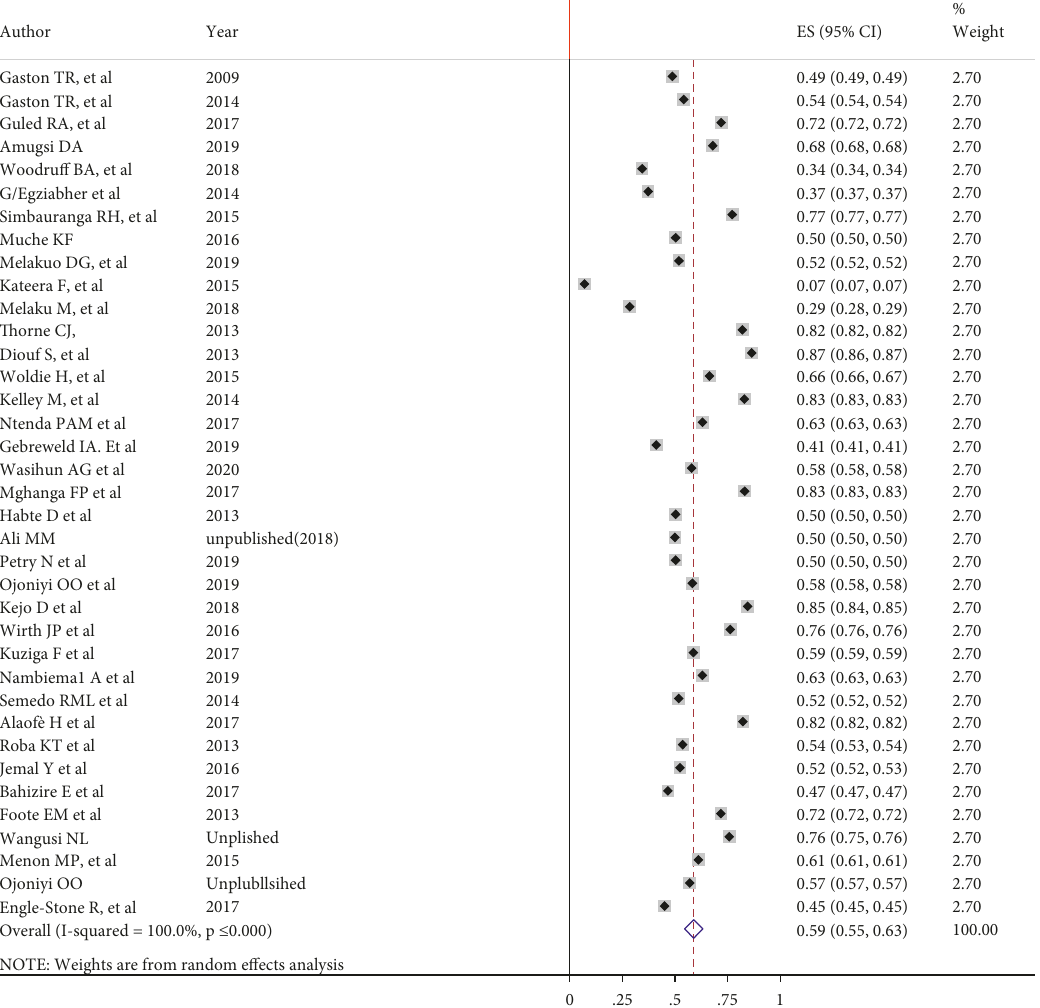
Figure 2: Forest plot for pooled prevalence of anemia among under-five children in Africa, 2009–2020.